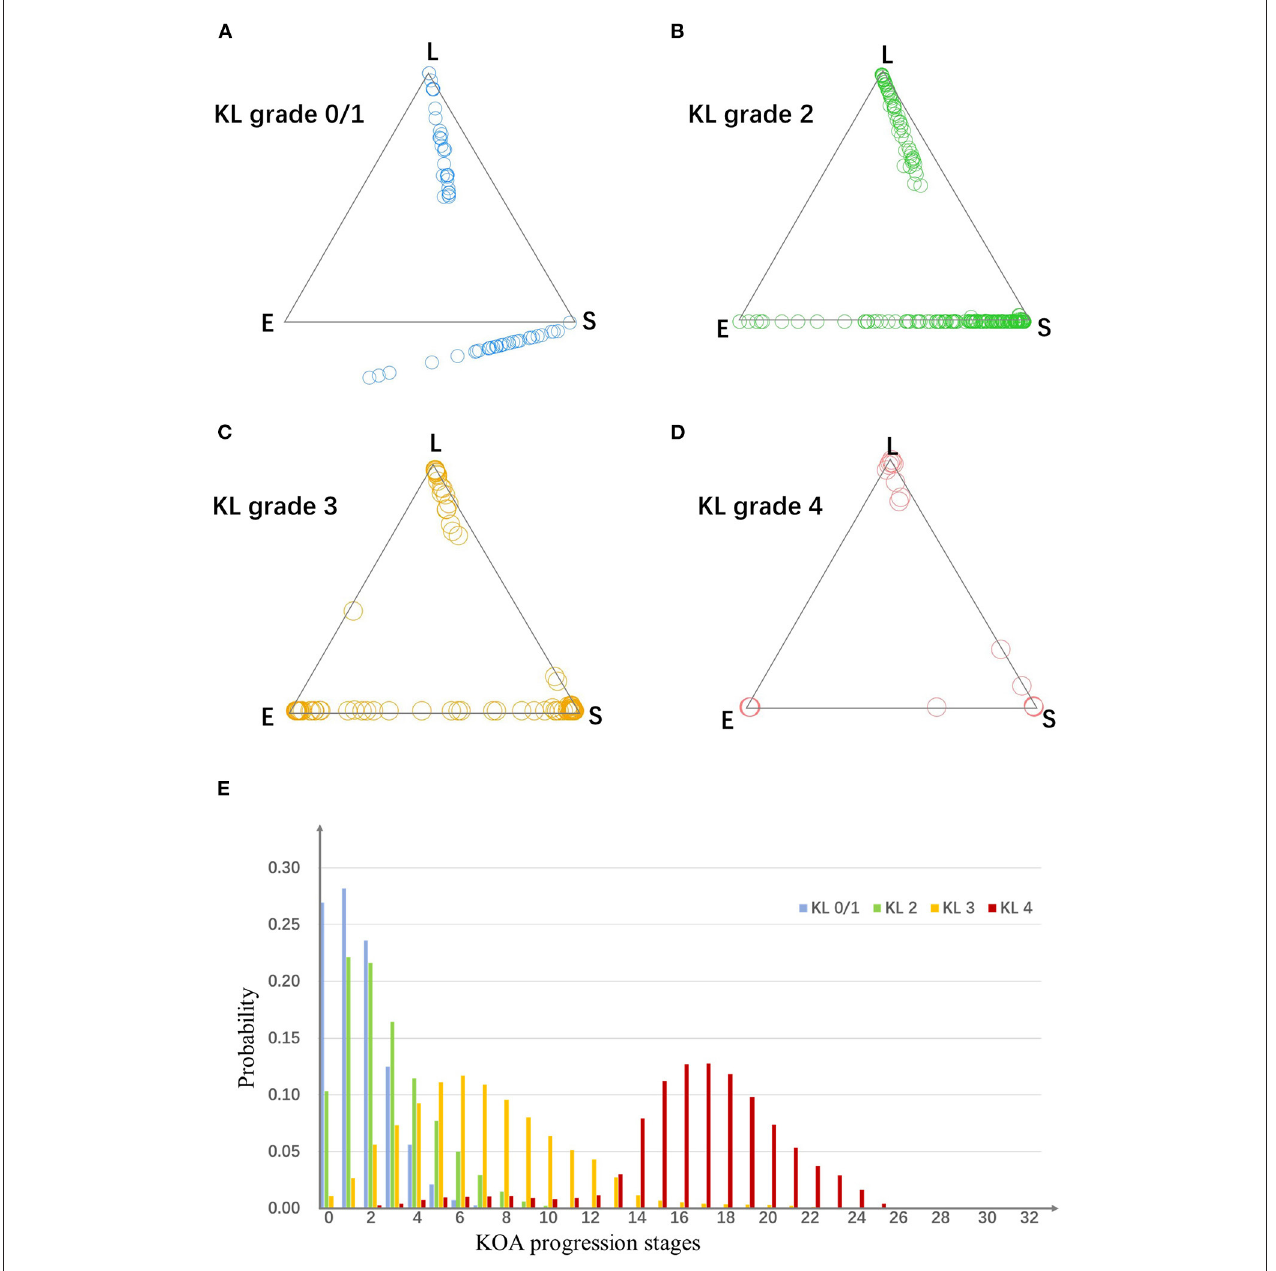
FIGURE 3 | (A–D) The assign ability of subtypes and stages. Plots in four scatter plots indicate knees from four KL grade groups. For a triangle scatter plot, each corner indicates a probability of 1 of assigning to a particular subtype, and 0 for the other two subtypes; the center point of the triangle indicates a probability of 1/3 of assigning to each subtype. (E) The probability of knees from each KL grade group belong to each stage. E, early pain; S, structural lesions concurrence pain; L, late